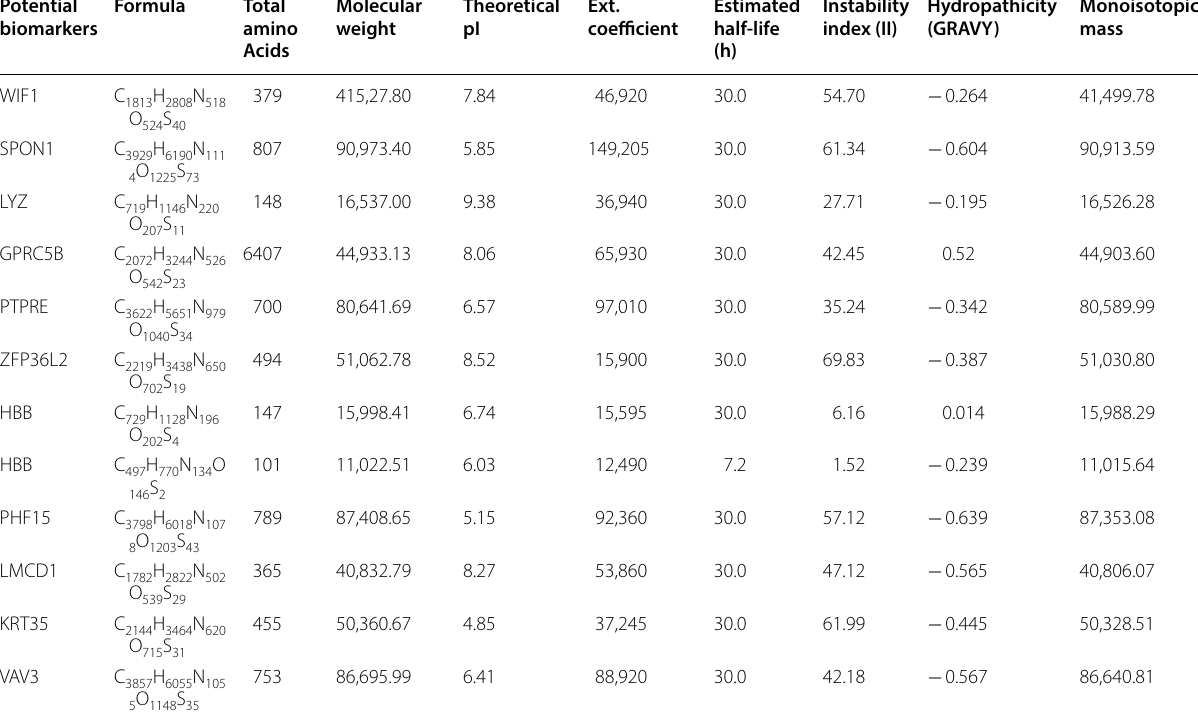
Table 3 Physicochemical properties of selected potential biomarkers using ProtParam, ProtScale, and PeptideMass tools Potential Formula Total Molecular biomarkers amino Acids